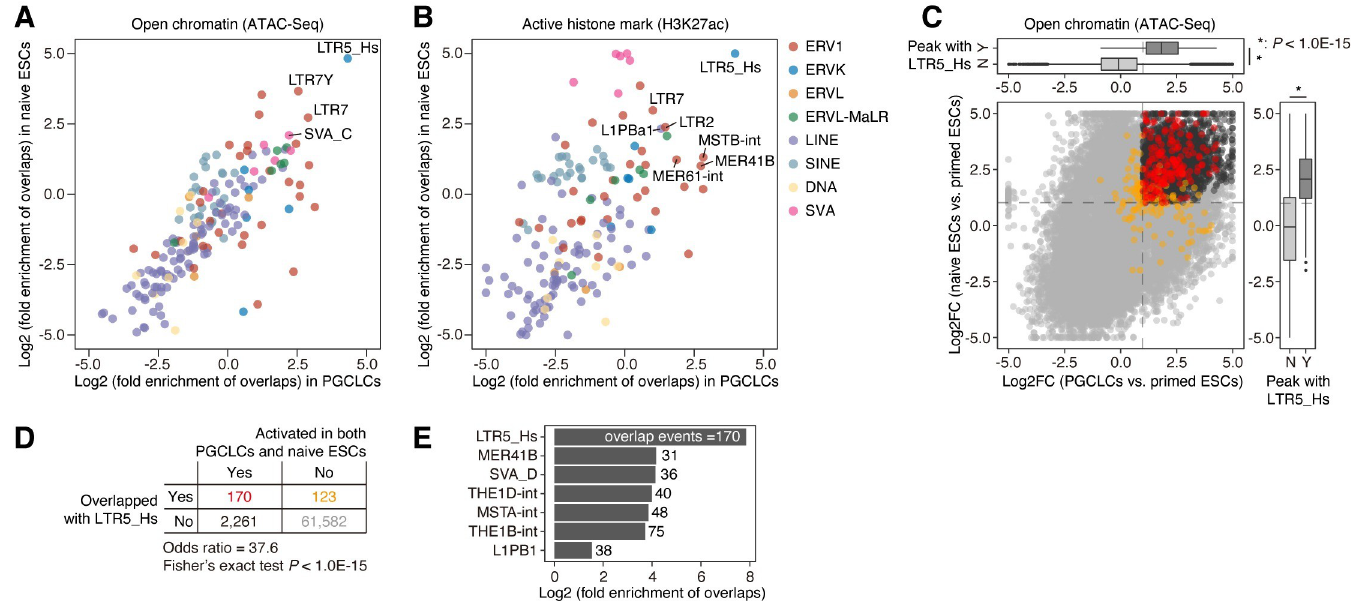
Fig 3. Potential enhancer activity of LTR5_Hs in PGCLCs and na ï ve ESCs. (A and B) Fold enrichment of the genomic overlap between TE loci and the peaks of ATAC-Seq ( A ) and ChIP-Seq targeting an active histone mark, H3K27ac ( B ). The fold enrichment value compared to the random expectation was calculated by the genomic permutation test. The X-axis and Y-axis indicate the log2-transformed fold enrichment values in PGCLCs and na ï ve ESCs, respectively. The ATAC-Seq and ChIP-Seq data originated from Pontis et al. [22] and Chen et al. [29]. (C) Upregulation of the chromatin accessibility of LTR5_Hs loci in PGCLCs and na ï ve ESCs compared to primed ESCs. For each ATAC-Seq peak (i.e., open chromatin region), the log2 FC scores of the chromatin accessibility in PGCLCs vs. primed ESCs (the X- axis) and na ï ve ESCs vs. primed ESCs (the Y-axis) are shown. In the main panel, the peaks overlapping with LTR5_Hs are colored red or orange. The peaks are colored red or black if they were upregulated in both PGCLCs and na ï ve ESCs (log2 FC > 1; FDR < 0.05). The color scheme is summarized in ( D ). In the upper and right panels, the marginal distributions for the X- and Y-axes, respectively, are shown (Y [Yes], overlapped with LTR5_Hs; N [No], not overlapped). An asterisk denotes P < 1.0E-15 based on the two-tailed Wilcoxon rank sum test. (D) The enrichment of LTR5_Hs in the ATAC-Seq peaks upregulated in both PGCLCs and na ï ve ESCs compared to primed ESCs. The P value was calculated with Fisher’s exact test. (E) The enrichment of the various TE subfamilies in the ATAC-Seq peaks was upregulated in both PGCLCs and na ï ve ESCs. The fold enrichment value compared to the random expectation and the statistical significance were computed with the genomic permutation test. The number of overlapping events is shown on each bar. The results for TEs with significant enrichment (FDR < 0.05; log2 fold enrichment > 1; overlap events > 20) are